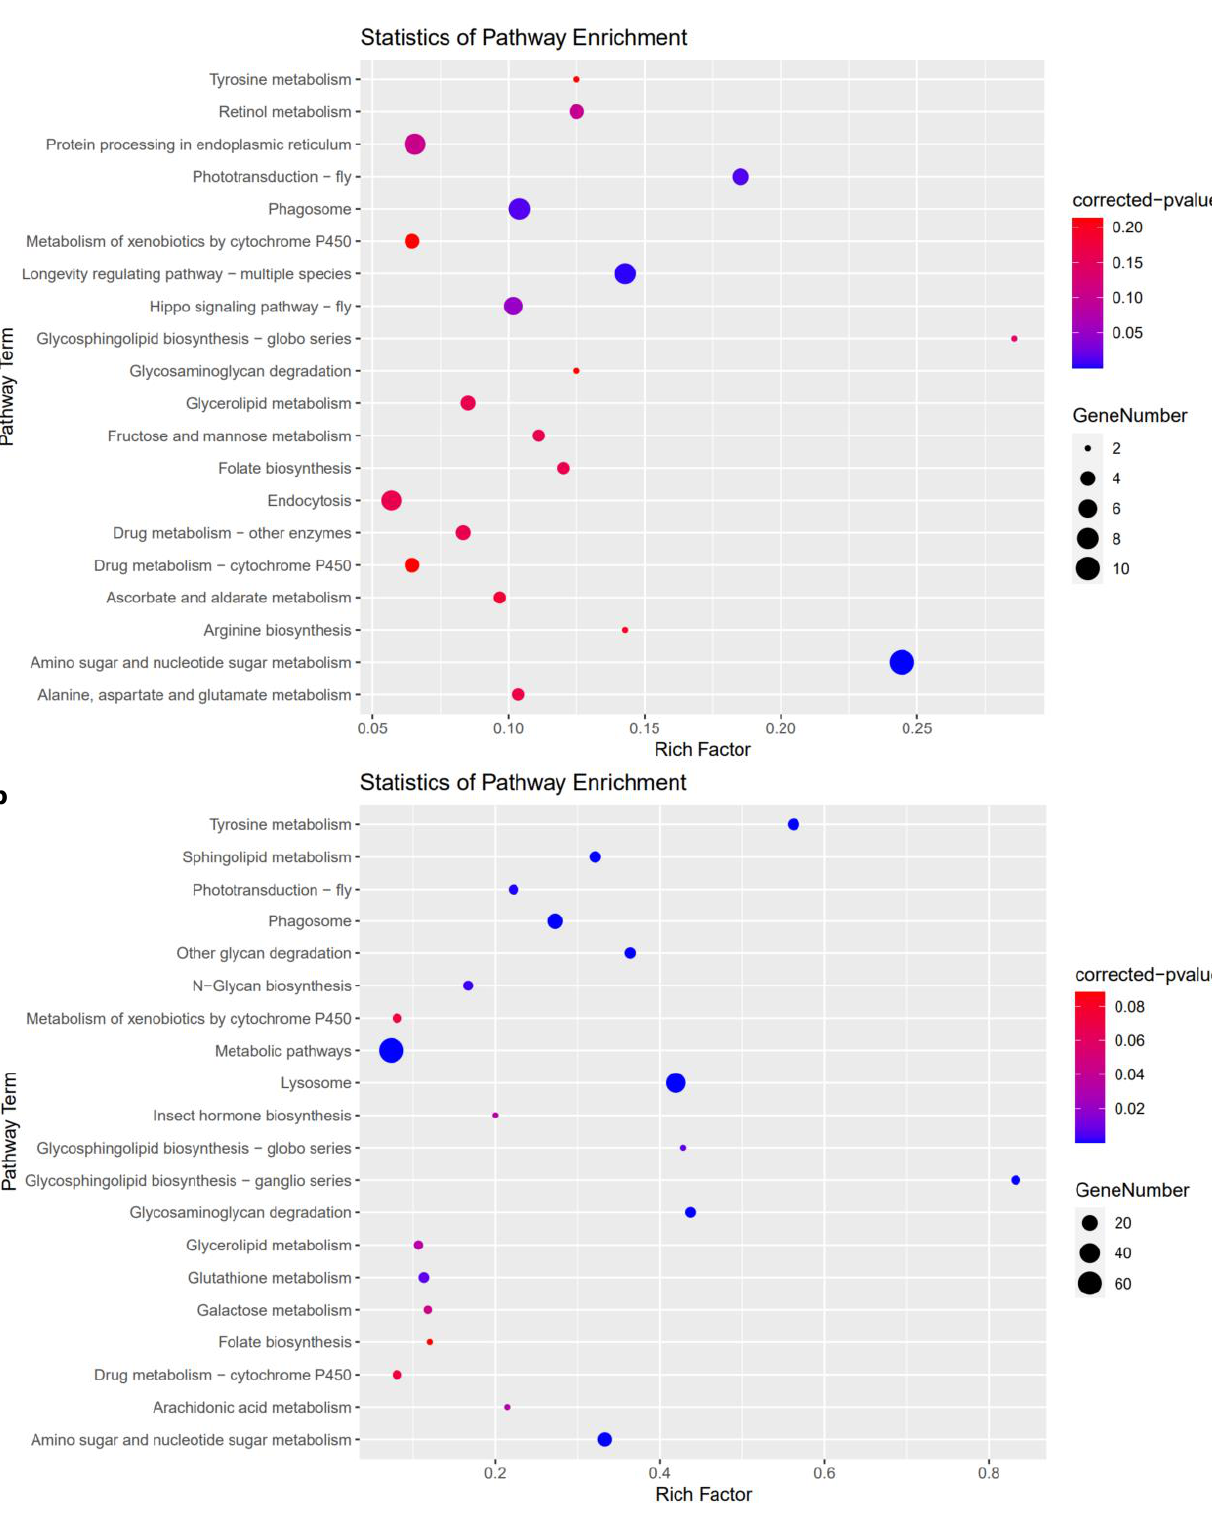
Figure 5. The KEGG significant enrichment pathway in LS _ E vs. CG _ E group. ( a ) Up-regulation pathways in LS _ E vs. CG _ E group; ( b ) down-regulation pathways in LS _ E vs. CG _ E group.